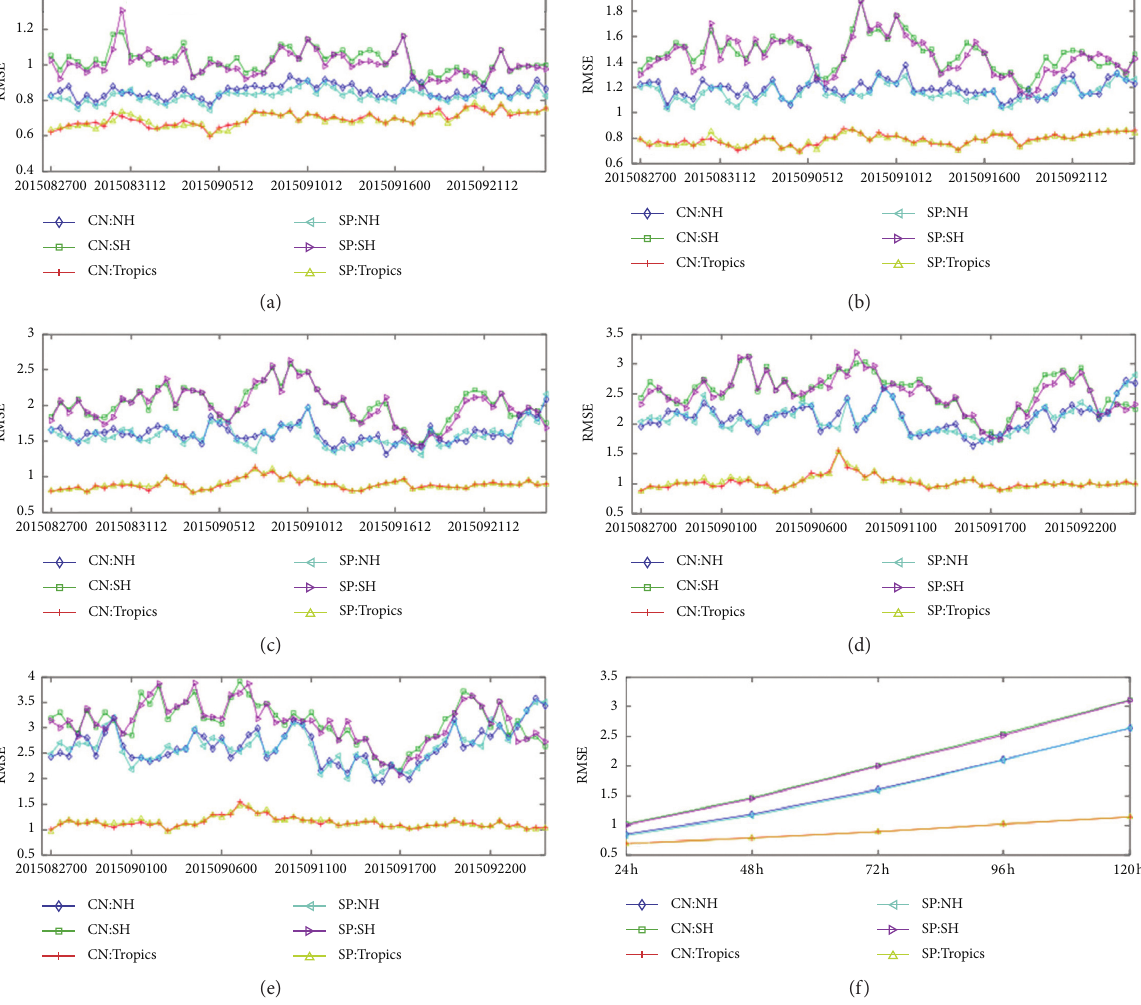
Figure 13: (a) RMSE of temperature versus 24-hour forecast time at 500hPa. (b–e) RMSE of temperature versus 48h, 72h, 96h, and 120h forecast time at 500hPa, respectively. (f) The mean